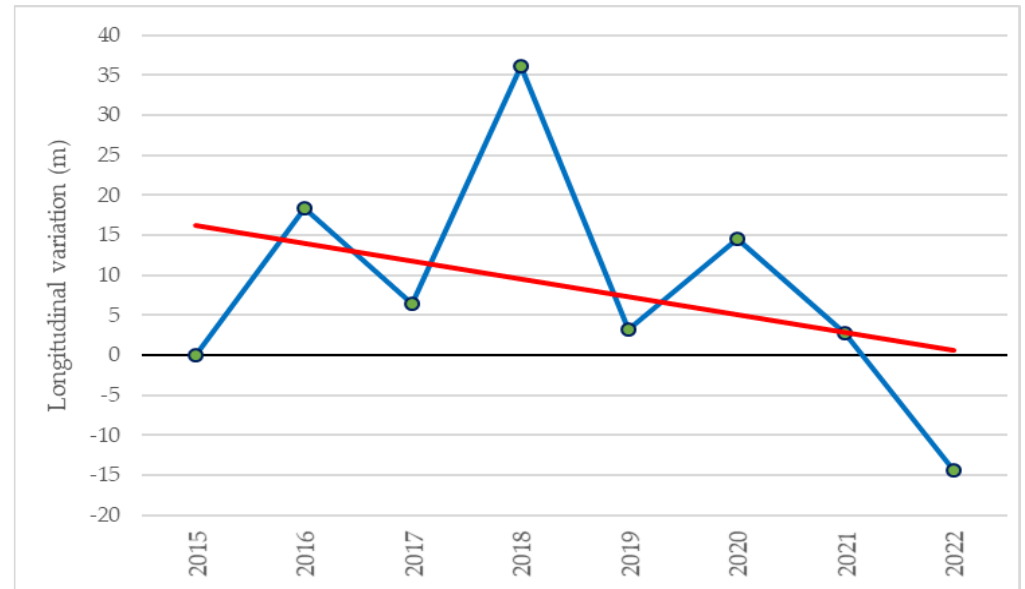
Figure 16. Evolution of the Infierno Glacier (Glacier front monitoring station). Period 2016 – 2022. Longitudinal variation, data in meters. References on position in 2015 and trend line (red).